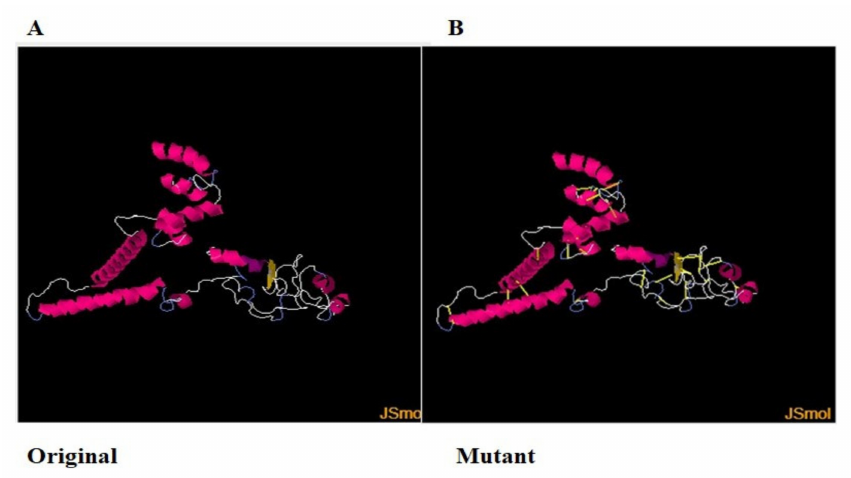
Figure 6. ( A ). Original wild structure of the vaccine construct and ( B ) mutated structure of the vaccine. The yellow sticks are the disulfide bonds introduced via disulfide engineering.